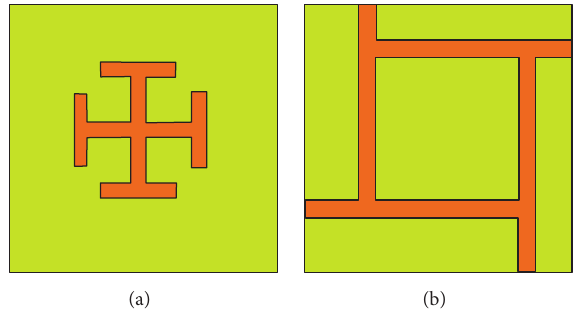
Figure 29: Front side (a) and back side (b) of the FSS unit cell useful to reduce the mutual coupling between DRAs